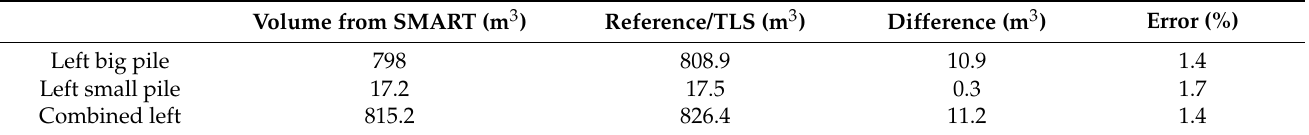
Table 7. SMART and TLS volumes estimates for post-repositioned stockpiles on the left side.